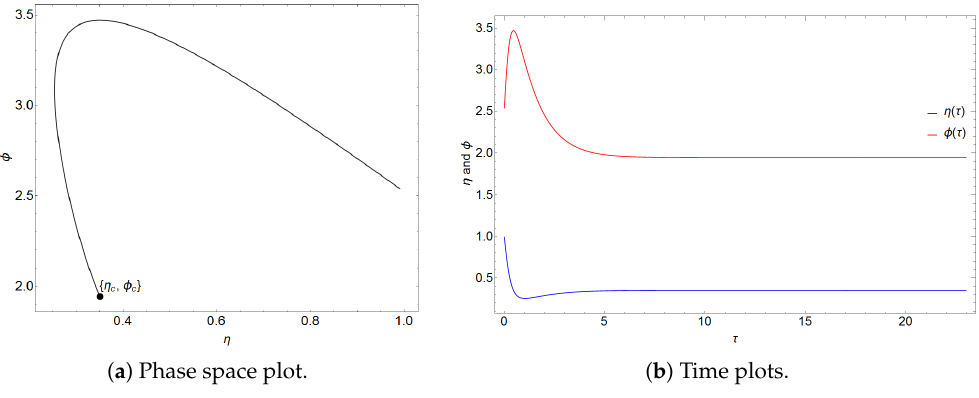
( a ) Phase space plot. ( b ) Time plots. Figure 3. Phase space plot with initial conditions η ( 0 ) = 0.99 and φ ( 0 ) = 2.54. Conversely, for the Q-Switching technique, let us choose a modulation of (cid:101) = 0.1 and a frequency 5 × 10 7 s − 1 with the same choice of parameters mentioned above. Figures 4a and 5a show that the asymptotically stable fixed point of Equation (17) turns into a limit cycle in the phase space. Similarly, the time plots from Figures 4b,c and 5b,c show that the inversion η decreases when the photons φ increase, which results in intense pulses of light as expected.